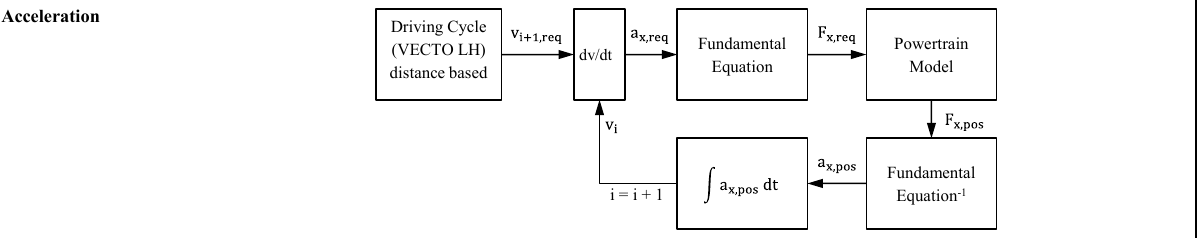
Figure A1. Simulation step of the detailed driving simulation in case of acceleration. The required acceleration, a x,req , is calculated based on the current vehicle velocity, v i , and the prescribed velocity in the next distance step, v i + 1,req